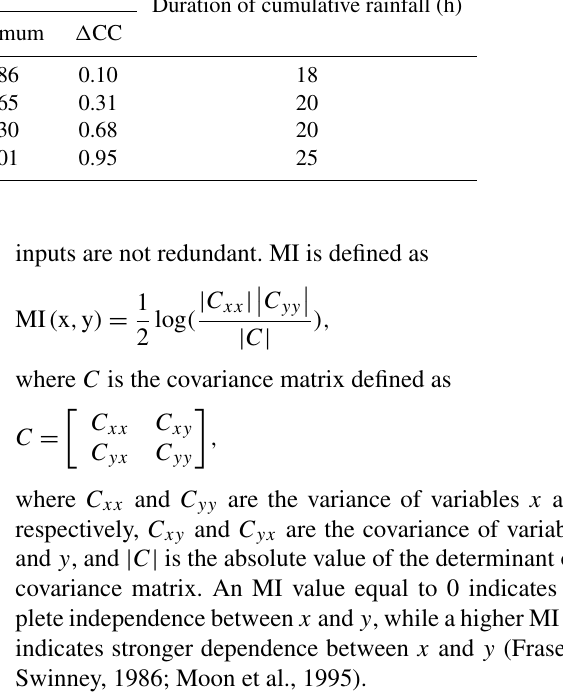
Duration of cumulative rainfall (h)